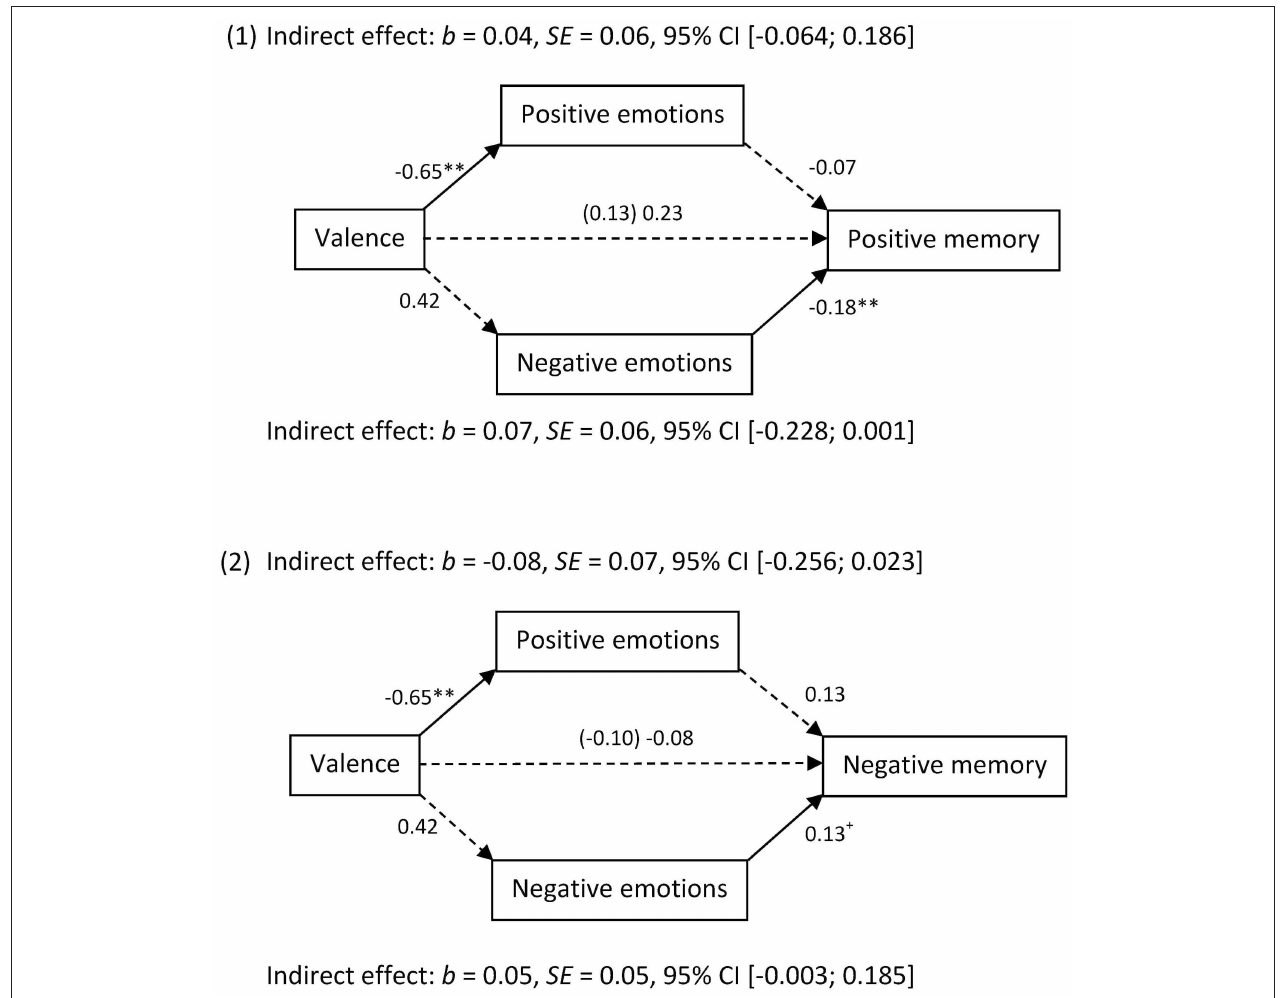
FIGURE 2 | Unstandardized coefficients of bootstrapping analyses of the effect of using doctors testimonials on memory performance regarding positive (1) or negative (2) DBS-related information via elicited positive or negative emotions.